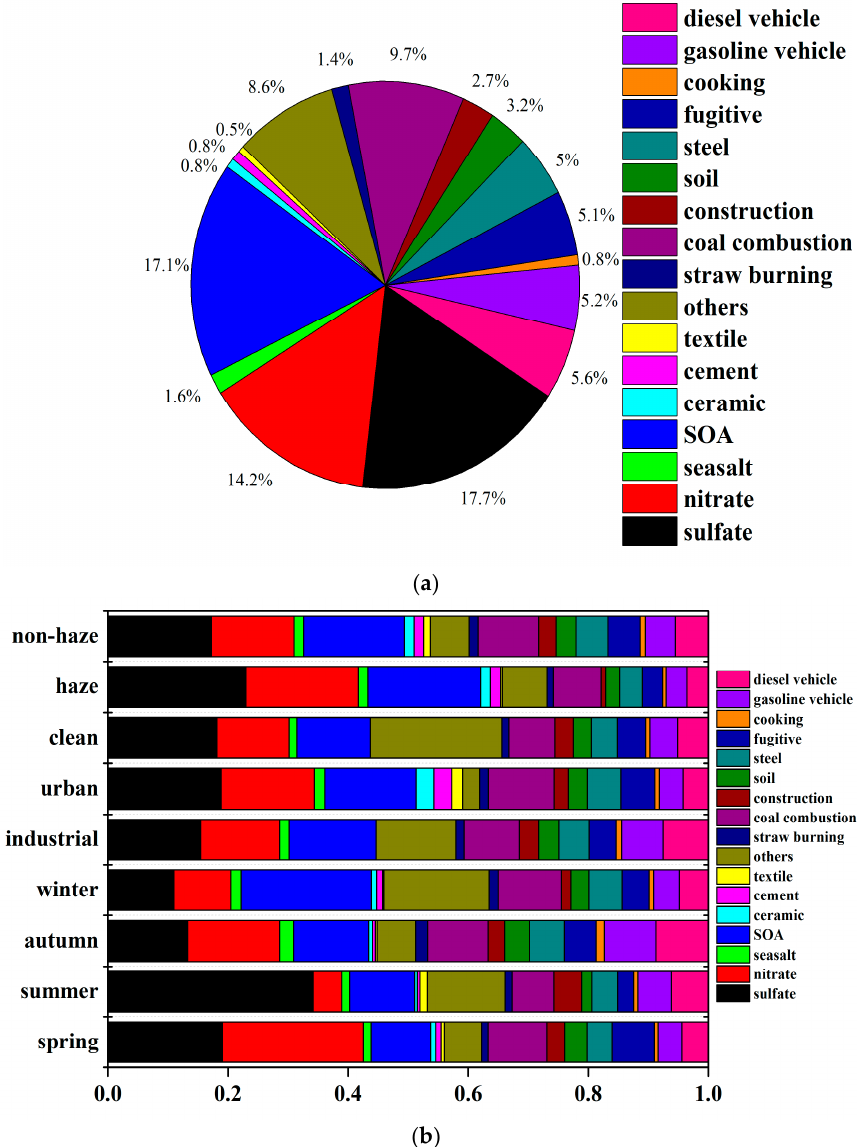
Figure 5. Source contribution fractions to the total PM 2.5 mass during the entire sampling period ( a ). Chemical species contributed to the total PM 2.5 mass concentrations at different seasons and different sites, as well as haze or non-haze days ( b ).